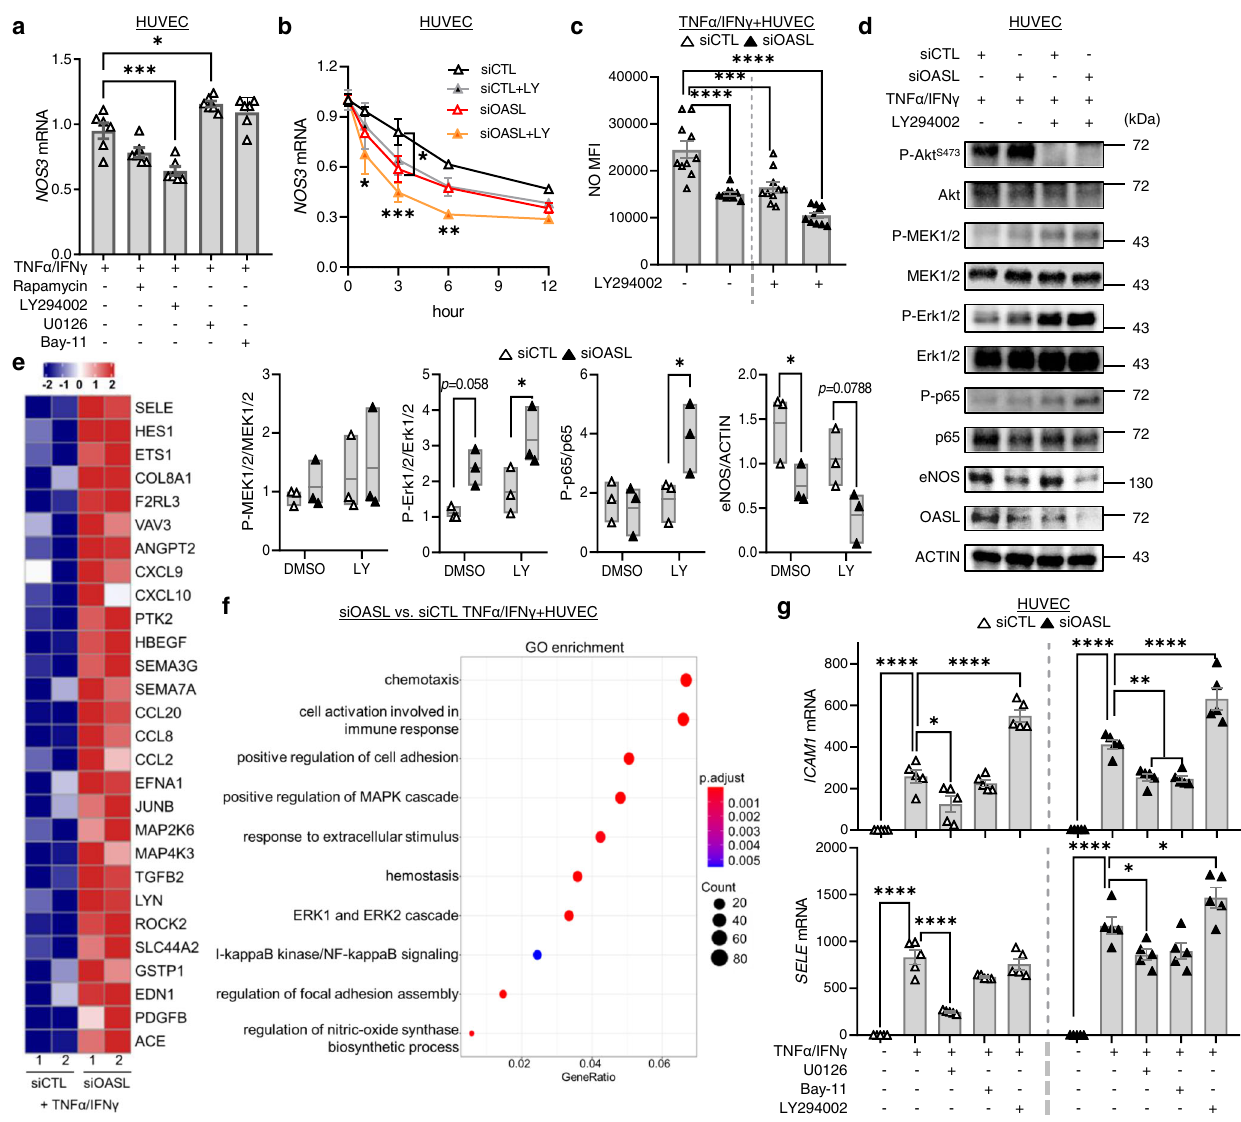
Fig. 6 | Endothelial OASL knockdown reduces NOS3 expression via the PI3K/ Akt-dependent pathway. a , b Quantitative RT-PCR analysis of NOS3 mRNA in HUVECspretreatedwiththemTORinhibitor,rapamycin,PI3Kinhibitor,LY294002, ERK 1/2 inhibitor, U0126, or the NF- κ B inhibitor, Bay-11 (20 μ mol/L for each) for 1h beforestimulationwithTNF- α andIFN- γ for3h(LY: p =0.0003,U: p =0.0206, n =6 per group) ( a ), or pretreated with the PI3K inhibitor, LY294002 (LY), transfected with siCTL or siOASL, and monitored over time (siCTL vs. siOASL 3h: p =0.0472; siCTL vs. siOASL+LY 1h: p =0.0146, 3h: p =0.0003, 6h: p =0.0036, n =4 per group)( b ). c , d siCTL-orsiOASL-transfectedHUVECswerepretreatedwiththePI3K inhibitor, LY294002 (20 μ mol/L), and stimulated with TNF- α and IFN- γ . c Quanti- tation of MFIvalues for DAF-DM diacetate staining of nitric oxide (NO; p < 0.0001; p =0.0004; p < 0.0001, n=10 per group). d Right: Western blot analysis of Akt, Erk1/2, NF- κ B (p65), and eNOS expression. Left: Quantitation of band density (P- ERK1/2: p =0.0355,P-p65: p =0.0407,eNOS: p =0.0478). e , f BulkRNA-seqanalysis performedonsiCTL-orsiOASL-transfectedHUVECsstimulatedwithTNF α andIFN